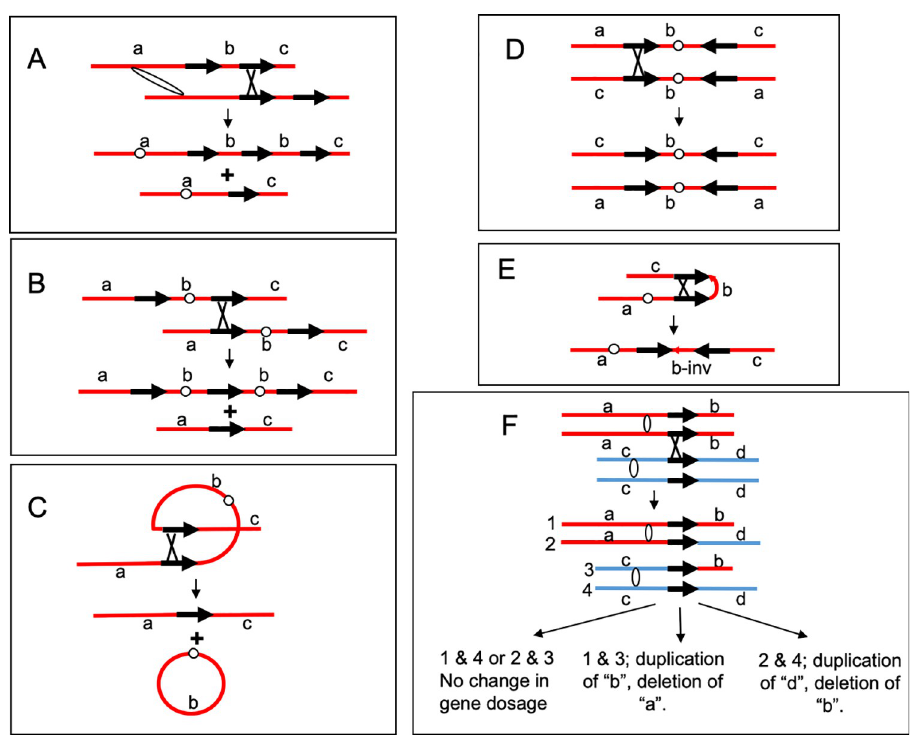
Fig 1. Ectopic recombination between Ty elements resulting in chromosome rearrangements. Ty elements are depicted with black arrows, and centromeres are shown as white ovals or circles. (A) An unequal crossover between Ty elements located on sister chromatids can produce both duplications and deletions. Deletions between direct repeats can also occur by the single-strand annealing pathway (Fig 2B). (B) A crossover between repeats on opposite chromosome arms of sister chromatids can generate dicentric and acentric chromosomes. (C) An intrachromatid crossover between repeats on opposite arms can produce an acentric linear chromosome and a centromere-containing circle. (D) A crossover between Ty elements located on opposite arms in inverted orientation can generate two isochromosomes. (E) A crossover between inverted Ty elements located on the same arm results in an inversion in the segment located between the Ty elements. (F) Recombination between repeats located on non-homologous chromosomes can generate reciprocal translocations. Depending on the segregation pattern of the chromosomes, this event can produce cells that have a coupled terminal duplication and a terminal deletion. The two homologs are shown in red and blue.